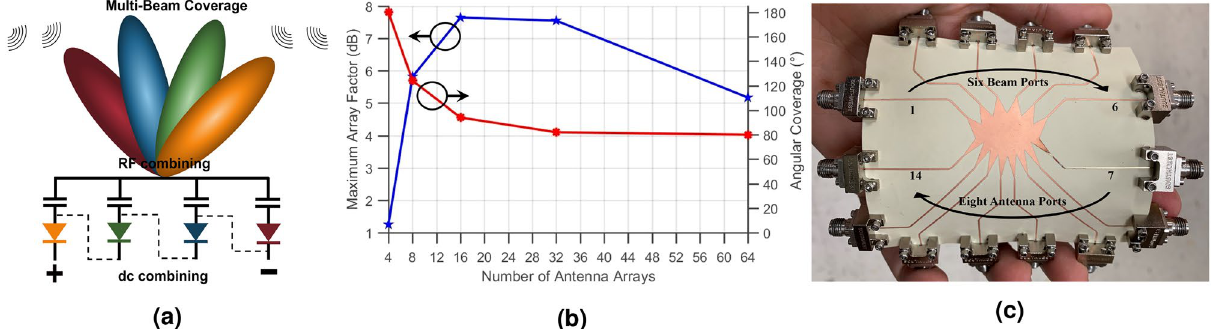
Figure 1. ( a ) Dual combining (RF + DC) enabled by the use of the Rotman lens between the antennas and the rectifiers, ( b ) plot of the simulated maximum array factors and angular coverages for different-size Rotman lenses and ( c ) picture of the fabricated Rotman lens